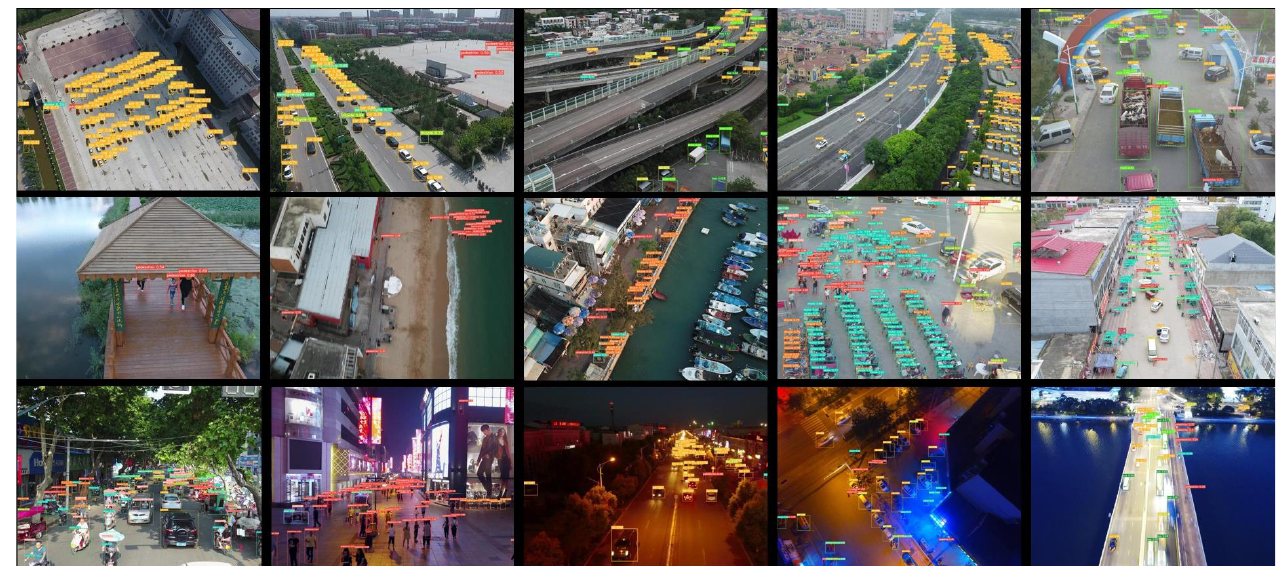
Figure 9. Qualitative results of the proposed TPH-YOLOv5++ on the VisDrone2021 test-challenge set. Different categories use bounding boxes with different colors. The performance is good at localizing tiny objects, dense objects, and objects blurred by motion.